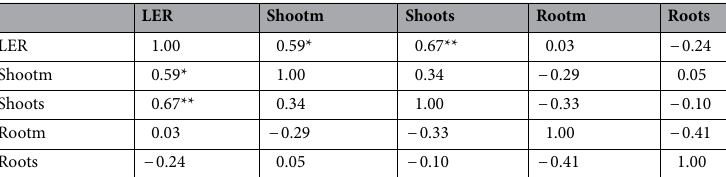
Table 3. The correlation between LER and above- and below-ground biomass. *, significant at 0.05 level; **, significant at 0.01 level. Shootm and Shoots represent the above-ground biomass of maize and soybean, respectively. Rootm and Roots represent the below-ground biomass of maize and soybean, respectively.